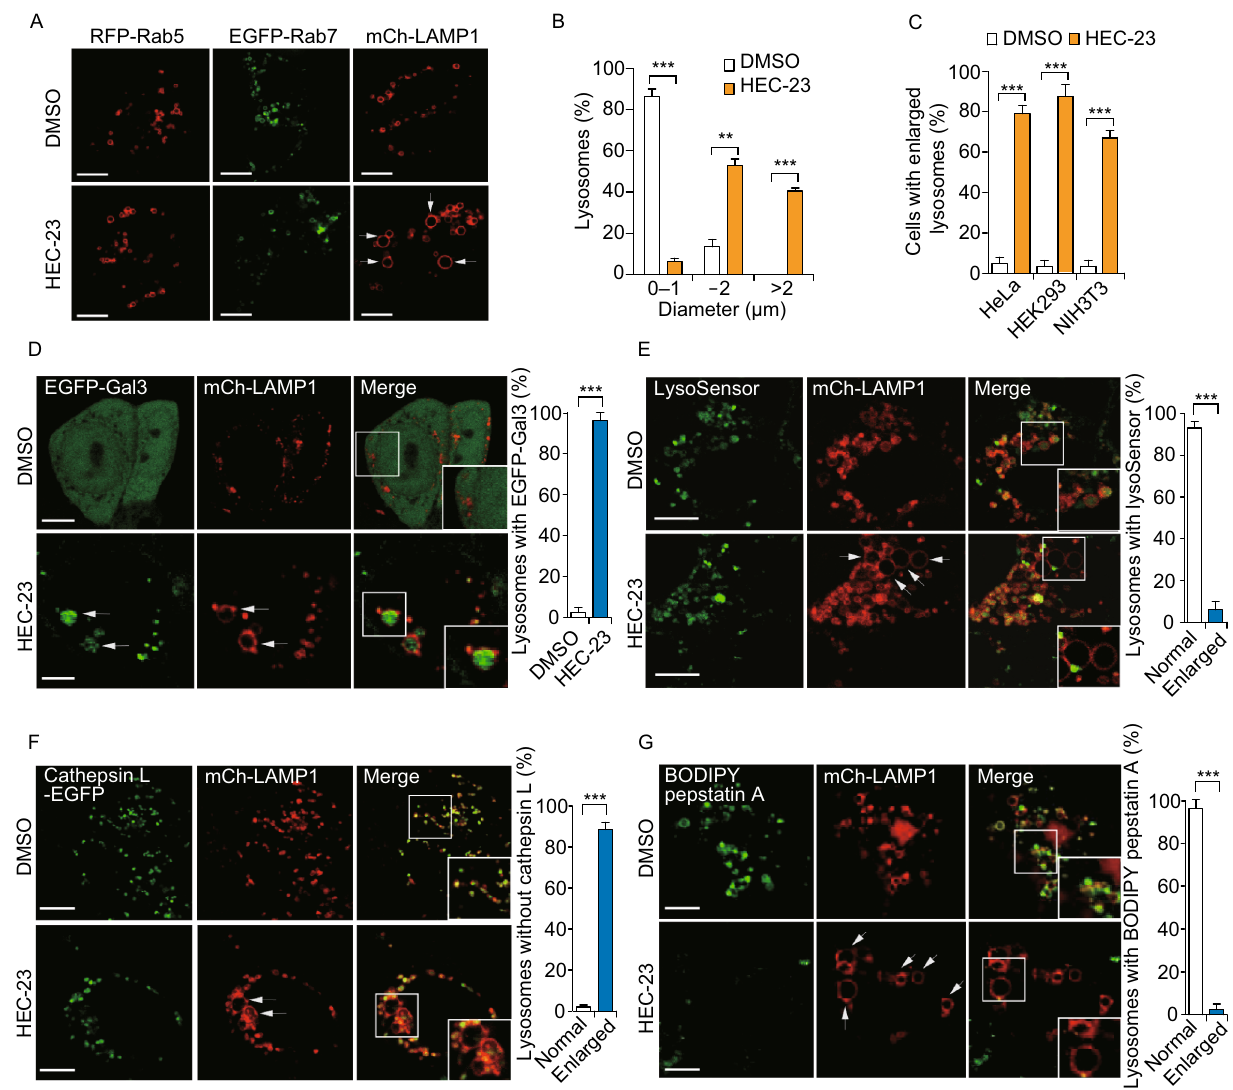
Figure 3. HEC-23 induces lysosomal damage in mammalian cells. (A and B) Images (A) and quanti fi cation (B) of HEC-23- induced enlargement of LAMP1-positive lysosomes in HeLa cells. (C) Quanti fi cation of HEC-23-induced lysosomal enlargement in the indicated cell types. (D) Representative images (left) and quanti fi cation (right) of EGFP-Gal3 in mCh-LAMP1-positive lysosomes in HeLa cells treated with HEC-23. (E) Representative images (left) and quanti fi cation (right) of LysoSensor Green staining in mCh- LAMP1-positive lysosomes in HeLa cells treated with HEC-23. (F) Representative images (left) and quanti fi cation (right) of cathepsin L-EGFP in mCh-LAMP1-positive lysosomes in HeLa cells treated with HEC-23. (G) Representative images (left) and quanti fi cation (right) of BODIPY-Pepstatin A in mCh-LAMP1-positive lysosomes in HeLa cells treated with HEC-23. In (D – G), boxed regions in the merged images are magni fi ed and shown in the bottom right corners. Cells were treated with HEC-23 at 10 μ mol/L for 3 h. Data (mean ± SEM) were from 3 independent experiments. ** P < 0.01, *** P < 0.001. Bars represent 10 μ m in all